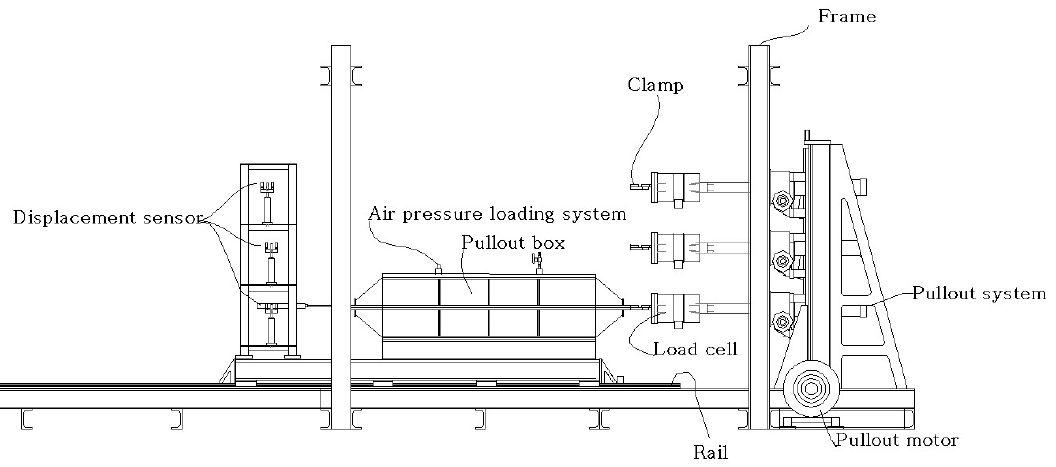
Figure 2. Configuration of pullout test apparatus (Kim [18]).